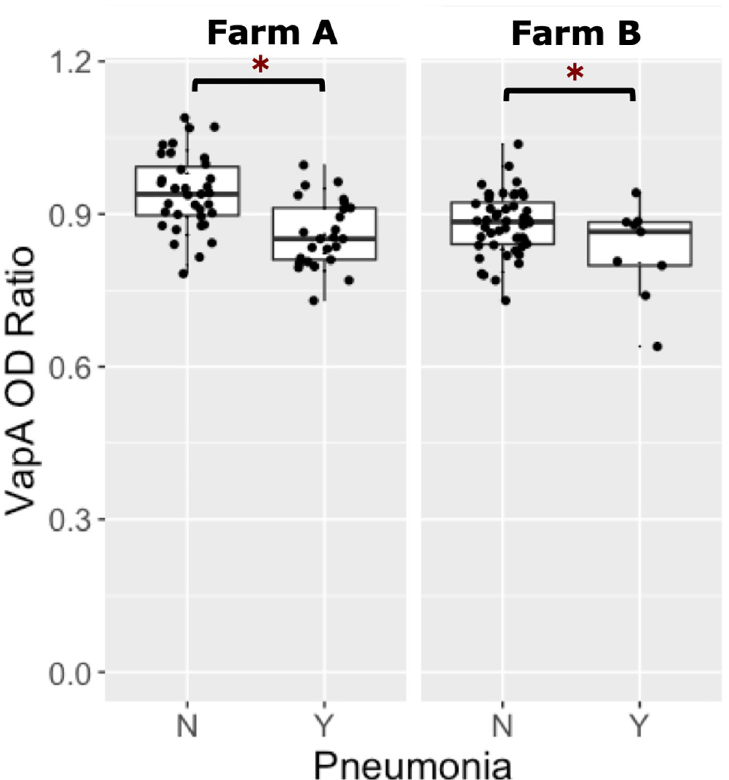
Fig 4. Foals transfused with R . equi hyperimmune plasma and their comparison of VapA optical density ratios with whether they developed pneumonia or remained healthy. Boxplots of optical density (OD) ratios from ELISAs measuring deposition onto purified VapA protein by serum antibodies in 117 foals transfused with R . equi hyperimmune plasma (RE HIP) stratified by pneumonia status, faceted by farm. Foals transfused with RE HIP at both farms that remained healthy (no pneumonia = ‘N’) had significantly higher (asterisks represent P < 0.05) VapA OD ratios than foals that developed pneumonia (pneumonia = ‘Y’). https://doi.org/10.1371/journal.pone.0250133.g004 guide for plasma production, ideally leading to improved consistency and quality of plasma produced by manufacturers. Variation in IgG antibody activity in RE HIP both among and within lots of products from each of 3 different commercial manufacturers has been